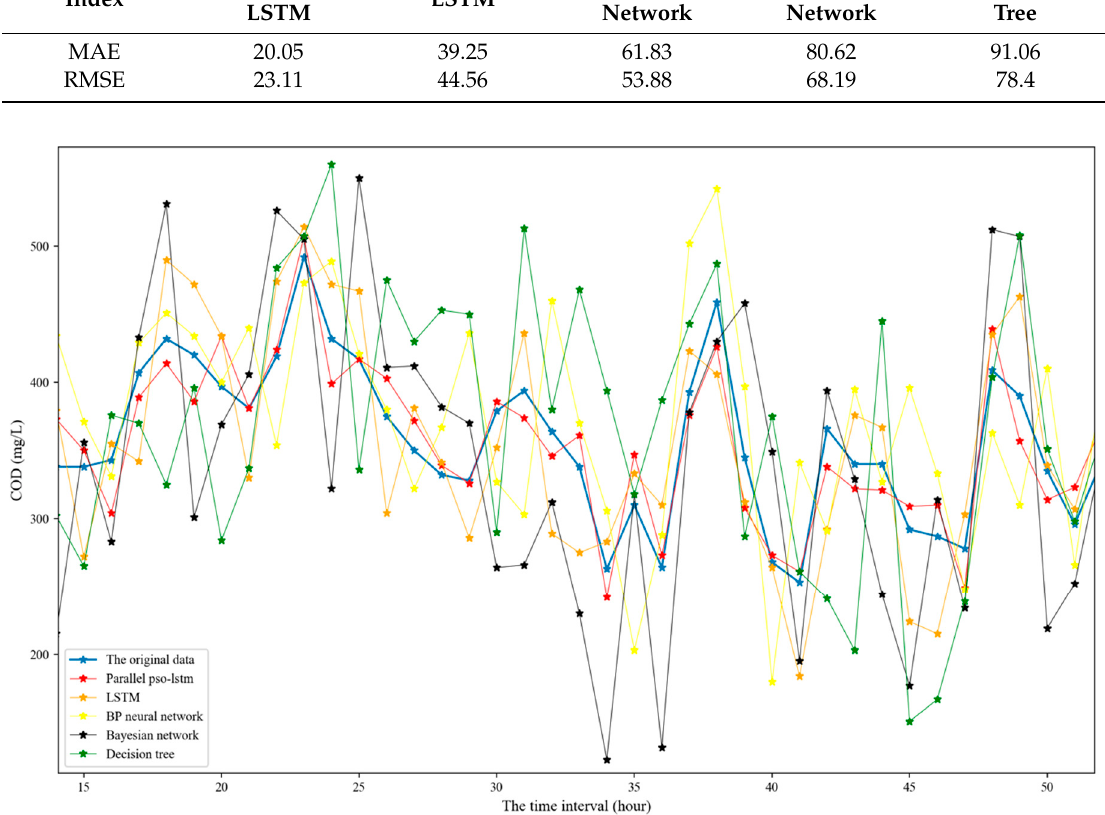
Figure 7. The prediction of COD time series using each model for 40 moments in time.